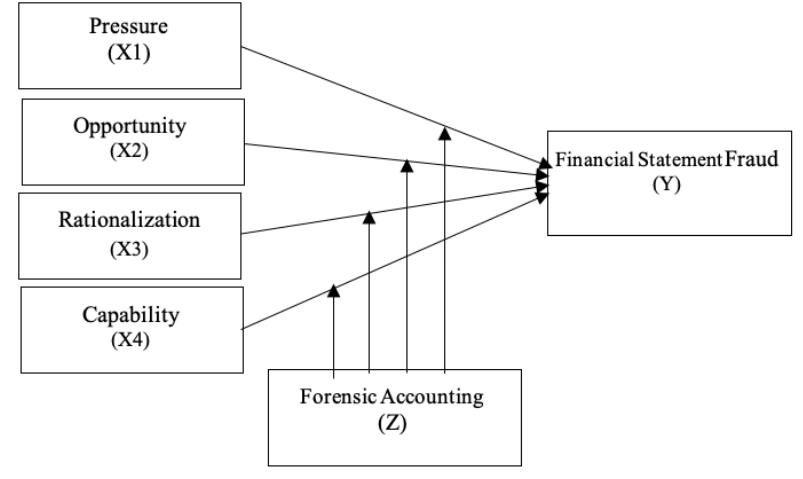
Figure 1: Theoretical framework